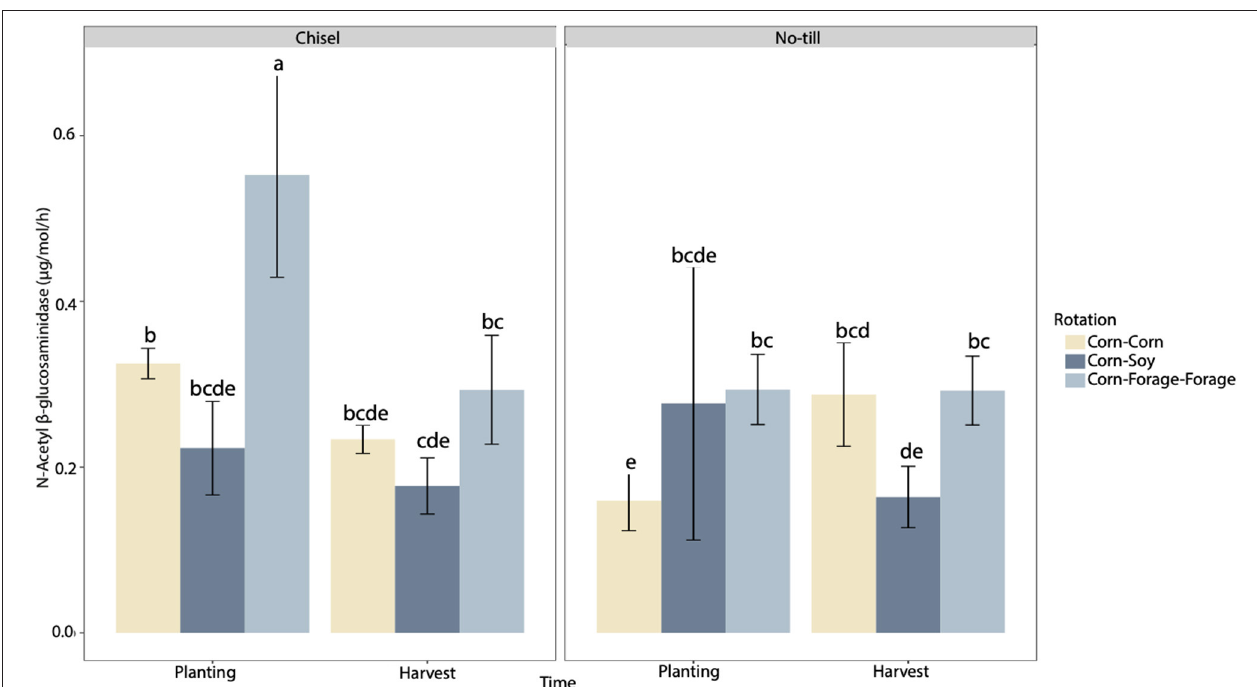
FIGURE 2 | N-Acetyl-B-Glucosaminidase (ug/mol/h) of three different crop rotations (corn–corn, corn–soy, corn–forage–forage) under no-till and chisel till treatments during two time points: planting (May 2020) and harvest (October 2020) ( n = 3). Error bars represent one standard error of the mean. Means separation reflected by lower-case letters represent significant differences at p < 0.05 across all systems and time points.